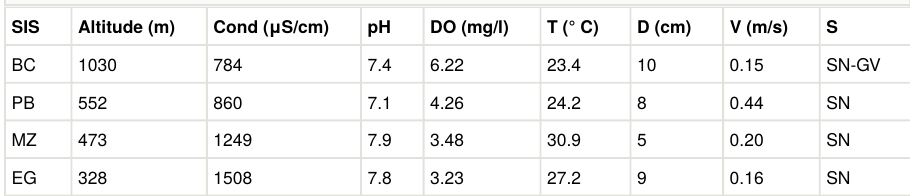
Habitat data for sites where Xestochironomus larvae were found. Site = SIS; Bacanuchi = BC; Puente Baviacora = PB; Mazocahui = MZ; El Gavilán = EG; Conductivity = Cond; Dissolved oxygen = DO; temperature = T; depth = D; water velocity = V; substrate = S; sand = SN; gravel =